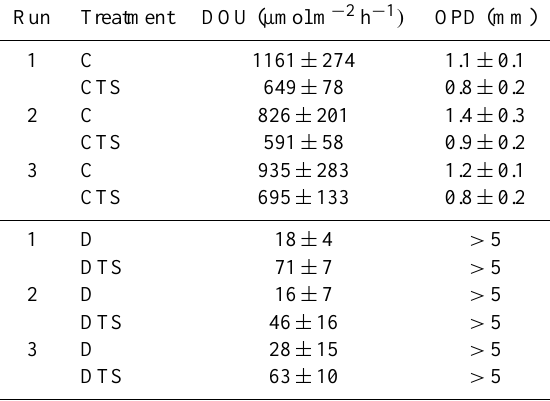
Table 3. Average diffusive O 2 uptake (DOU, mean ± 1SD, n = 5) across the visible sediment surface and O 2 penetration depth (OPD, mean ± 1SD) in bare intertidal (C) and depleted (D) sediments and deposit-underlying intertidal (CTS) and depleted (DTS) sediments. For CTS and DTS, OPD is the distances from the sediment–deposit to the oxic–anoxic boundary. The oxic–anoxic boundary in D and DTS was below 5mm depth, the maximum depth